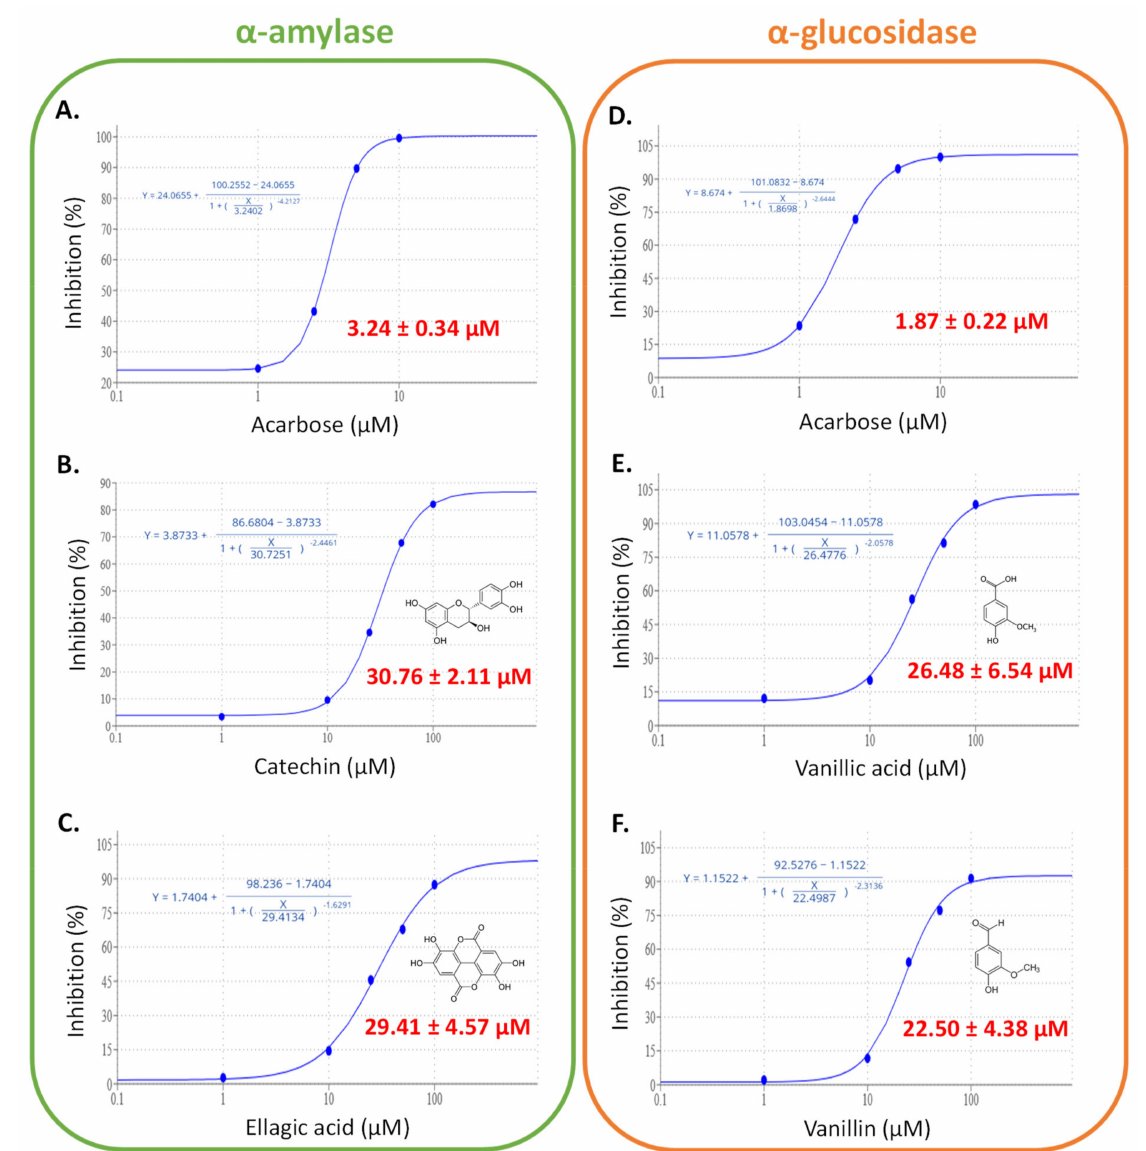
Figure 7. IC 50 curves (with background correction (subtract smallest response) for the inhibition of intestinal α -amylase by acarbose ( A ), ( − )-catechin ( B ) and ellagic acid ( C ), pancreatic α -amylase by acarbose ( D ), vanillic acid ( E ), and vanillin ( F ). Each experiment was performed in triplicate (curves without background correction (subtract smallest response) in order to show error bars are depicted in Figure